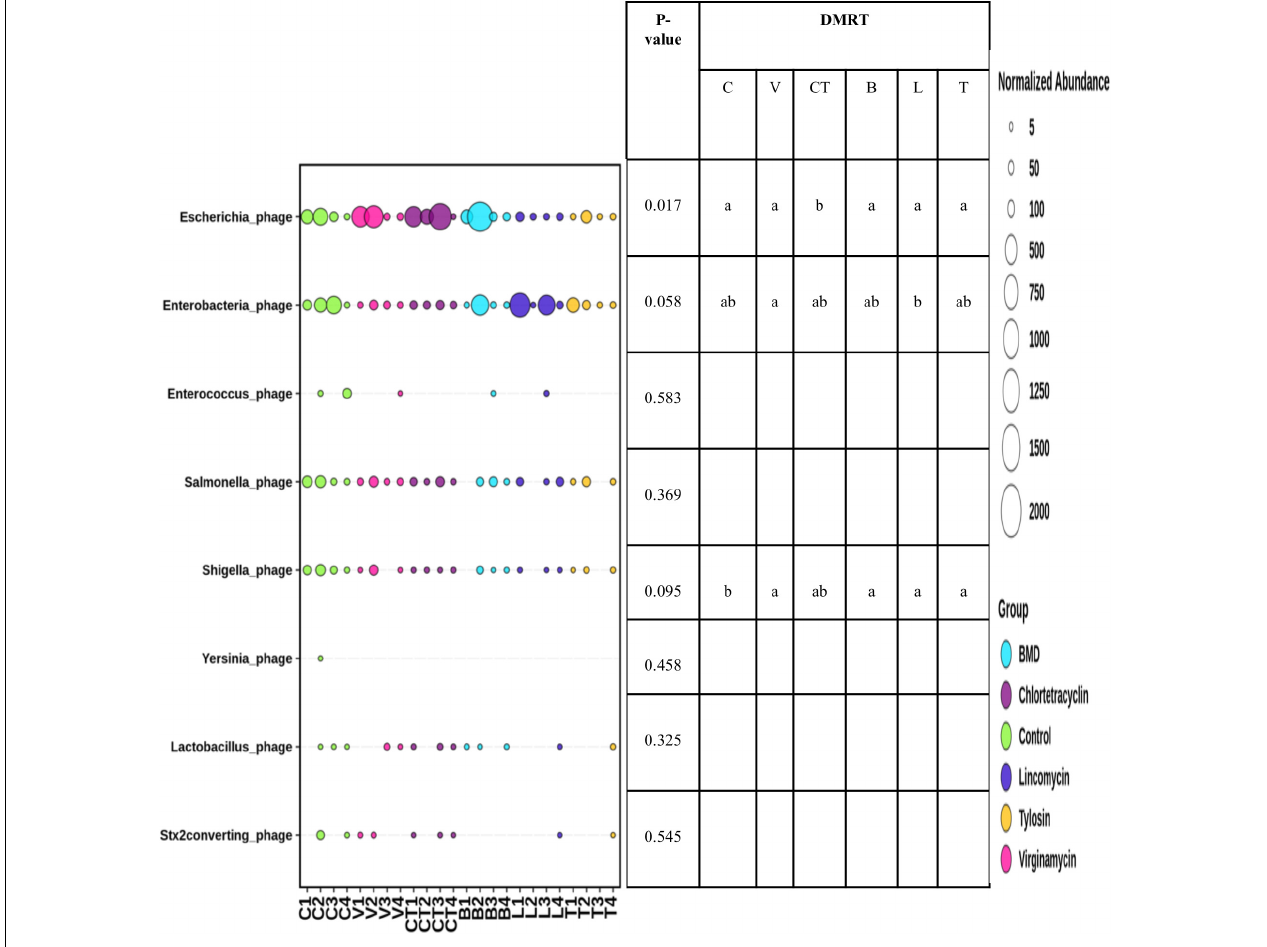
Faecalibacterium (18%), and Lactobacillus (15%) were higher with proportionately lesser populations of Akkermansia